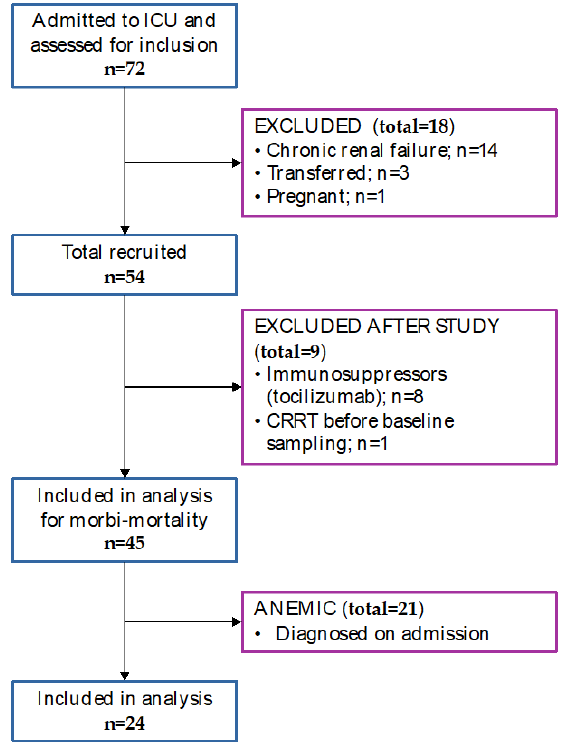
Figure 1. Flow diagram with numbers of patients assessed for eligibility, recruited, excluded, and analyzed.